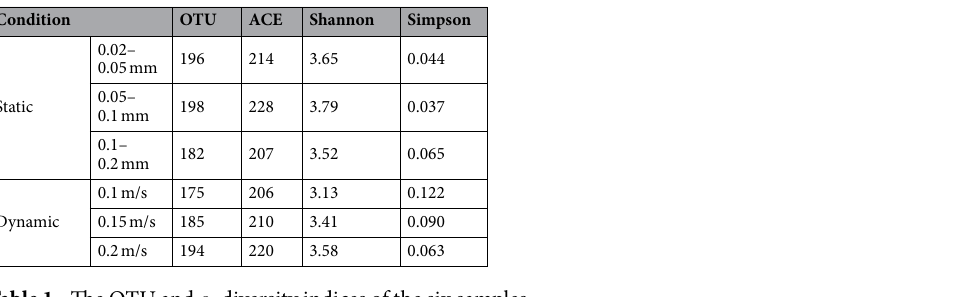
Table 1. The OTU and α -diversity indices of the six